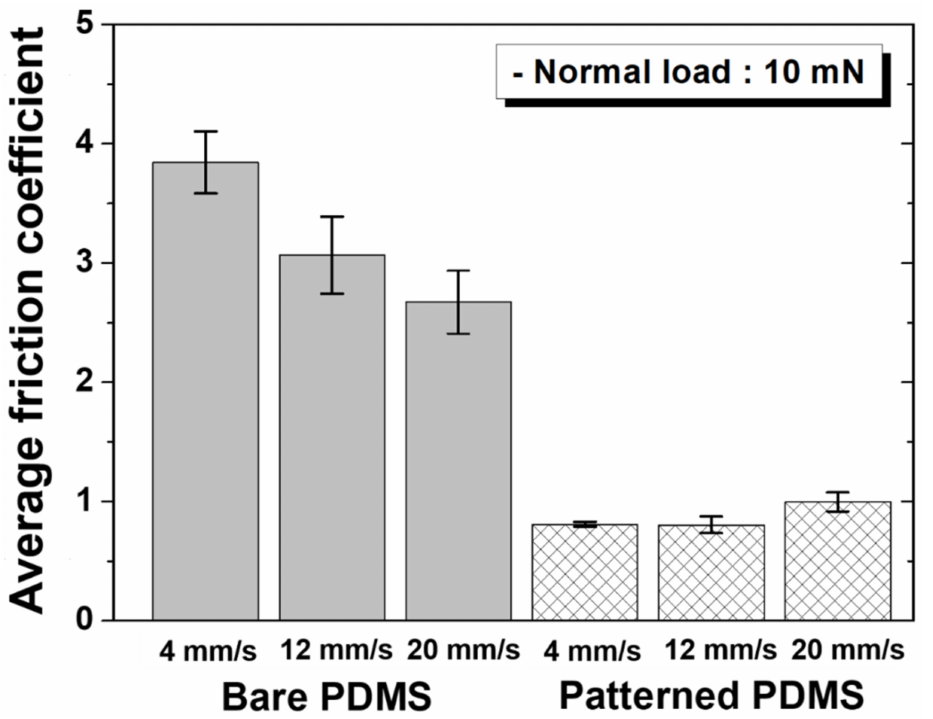
Figure 4. Average friction coefficients as a function of sliding speed under a normal load of 10 mN for bare PDMS and micro/nanopatterned PDMS.